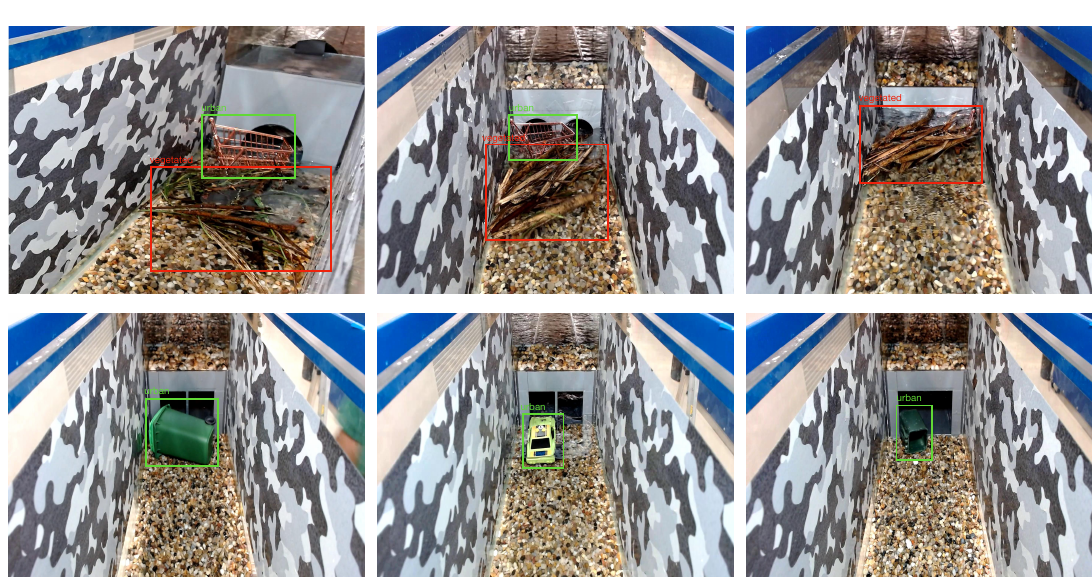
Figure 2. Annotated Simulated Samples from